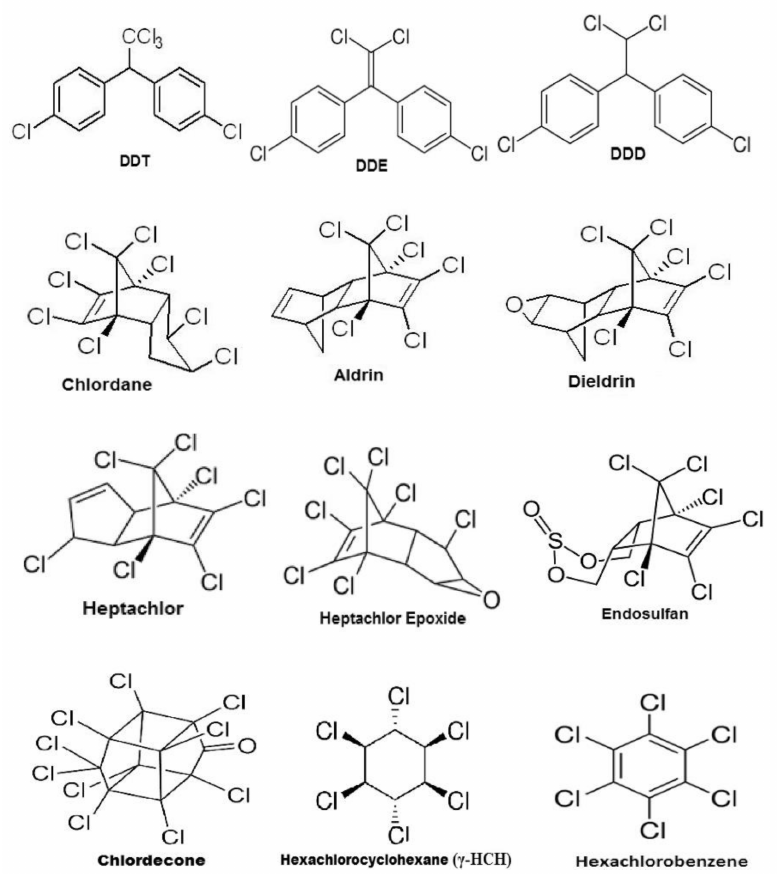
Figure 4. Structure of some of the organochlorine compounds [82]. Copyrights